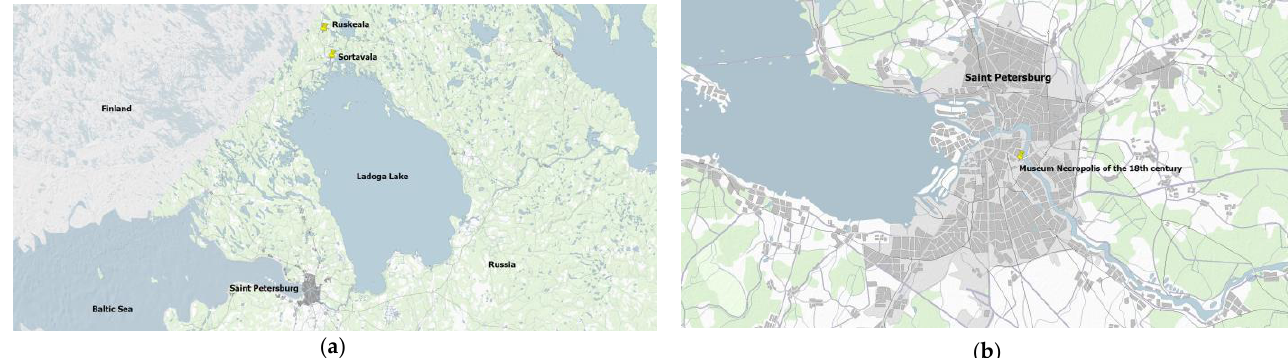
Figure 2. Location of sampling sites: ( a ) Ruskeala quarry; ( b ) Alexander Nevskay Lavra. Table 1. Climatic features of sampling sites.